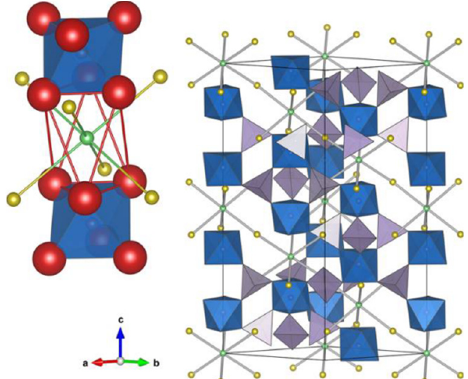
Figure 2. Representations of a typical NASICON structure. Blue octahedra are MO 6 units, purple tetrahedra are PO 4 units, green spheres are M1 sites and yellow spheres are M2 sites. Reprinted with permission from ref. [41]. Copyright 2014 American Chemical Society.